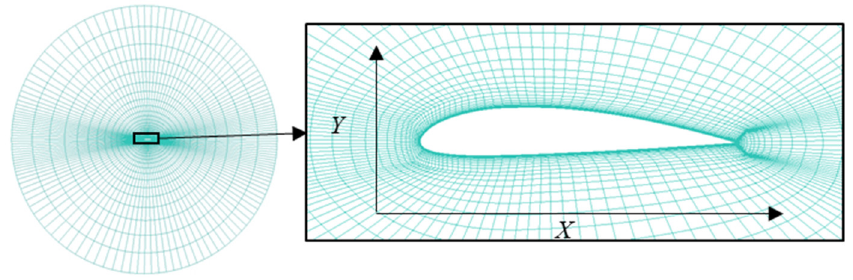
Figure 5. The grid of airfoil for 2D CFD simulation.